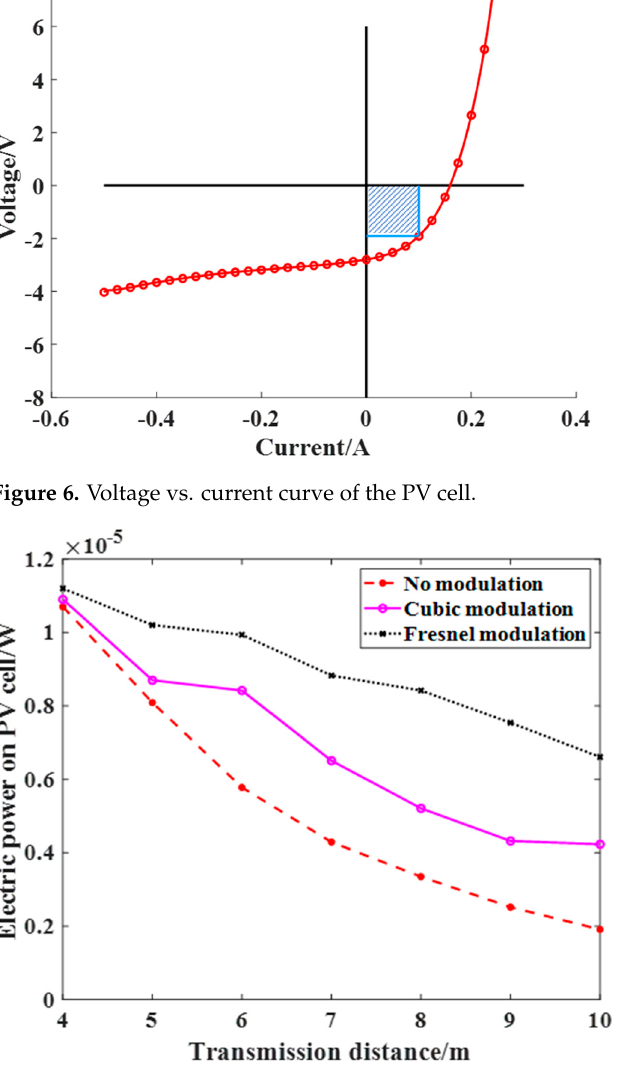
Figure 7. The maximum electrical power obtained by source metre conversion at different planes. Table 1. The values of b used in the